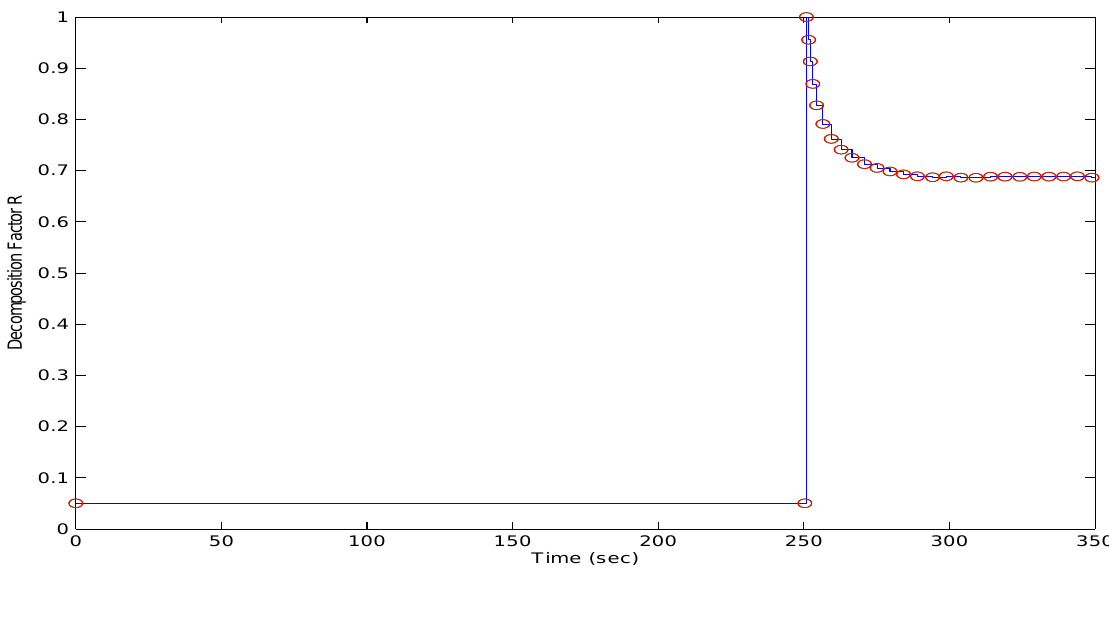
Figure 12 . QT–Decomposition factor R convergence over experimental time (Initial values